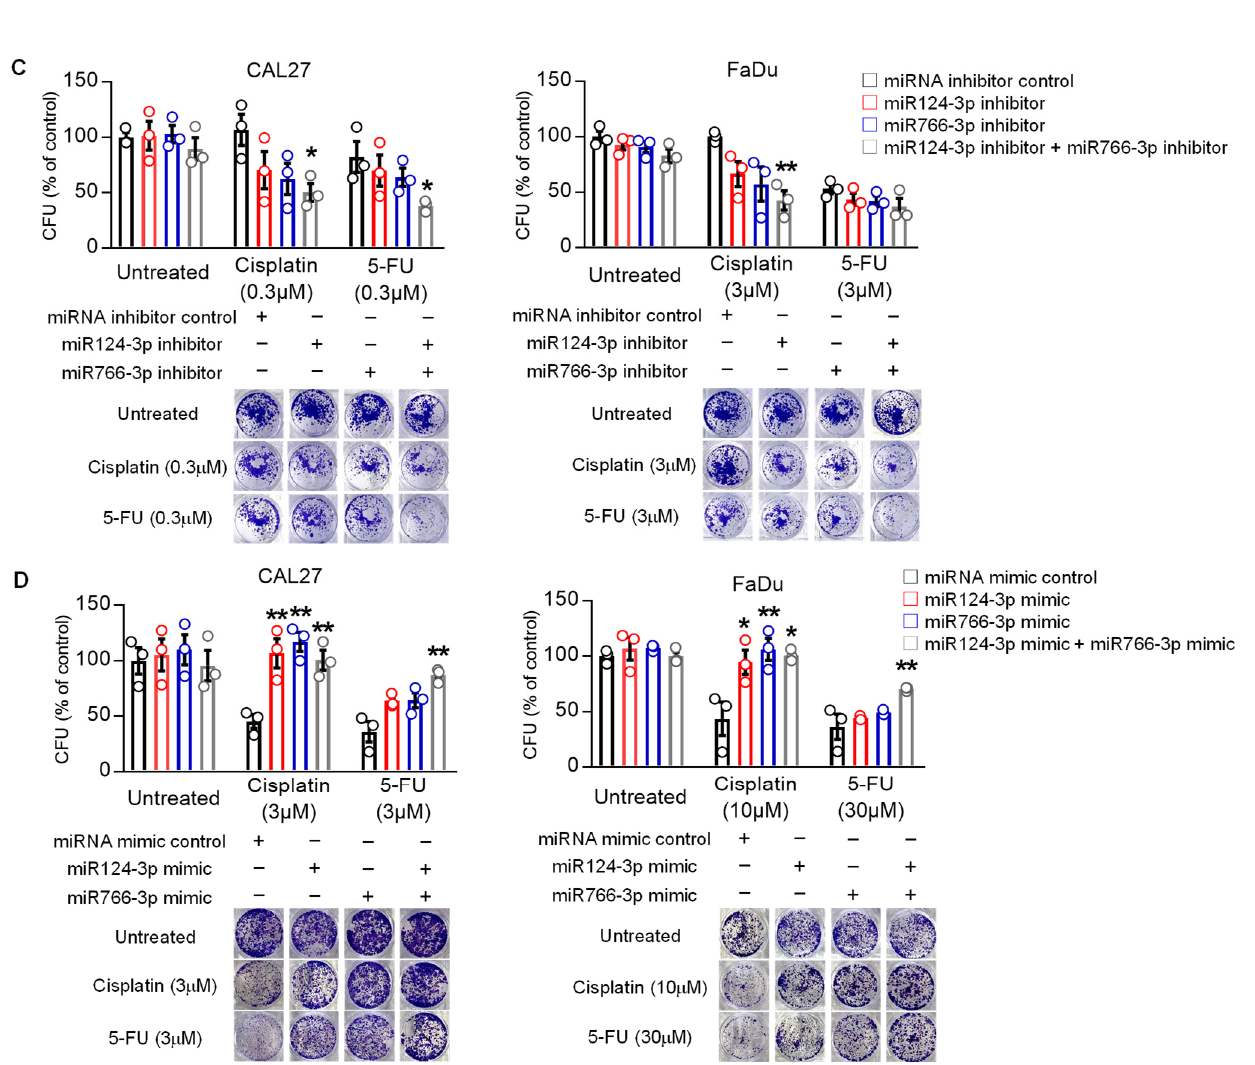
Figure 3. The effect of miR766-3p and miR124-3p expression on HNSCC cell apoptosis and clonogenic potential. ( A , B ) Measurement of apoptosis in CAL27 or FaDu cells in response to cisplatin or 5-FU ± 24 h prior to transfected with 10 nM miRNA inhibitors ( A ) or miRNA mimics ( B ). After 24 h of drug treatments, cells were stained for annexin V (FITC) and propidium iodide (PI) and then analyzed with flow cytometry. Dot plots data from this analysis are presented in Figure S2. ( C , D ) Measurement of clonogenic potential by colony formation assay. Cancer cells were treated with either 10 nM miRNA inhibitors ( C ) or miRNA mimics ( D ) for 24 h. Then, medium (DMEM + 10%FBS) was changed with or without indicated drug. Cells were allowed to grow for additional seven days, and after staining by crystal violet, colony formation units (CFU) were counted. A one-way or two-way ANOVA with Bonferroni’s correction for multiple comparisons was used to analyze group comparisons, and data are presented as means ± SD (n = 3). Each experiment was performed three times, and each time it included triplicate samples. * p < 0.05 and ** p <